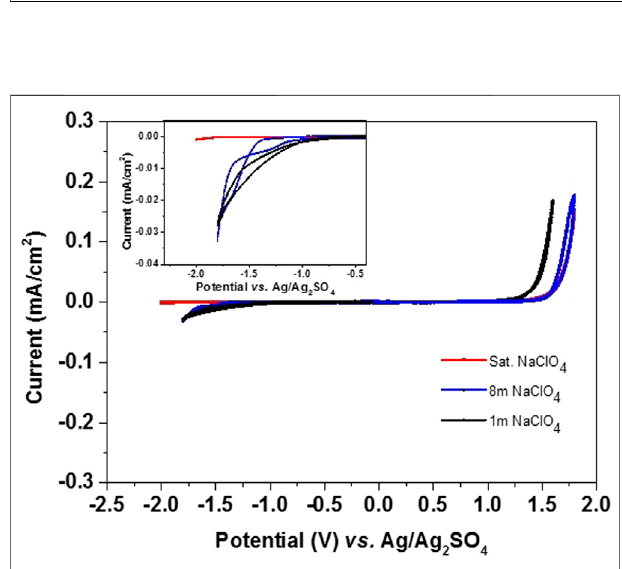
FIGURE 2 | CVs of the polymeric web substrate (case and current collector) at 1 mV/s scan rate with Ag/Ag 2 SO 4 RE and 1 m (pink), 8 m (blue), and saturated (red) NaClO 4 electrolyte solution. The inset in the fi gure shows the enlarged area of the negative potential range.